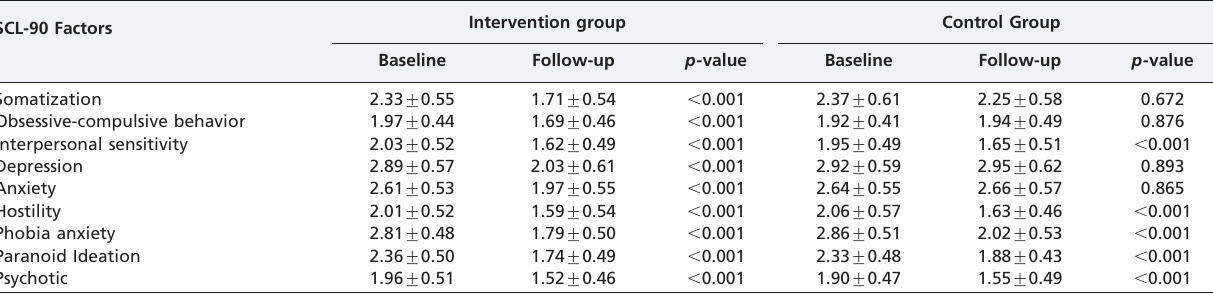
Table 3 - Comparisons of SCL-90 factor scores at the baseline and follow-up examinations for both groups (mean ¡ SD). SCL-90 Factors Intervention group Control Group Baseline Follow-up p- value Baseline Follow-up p-